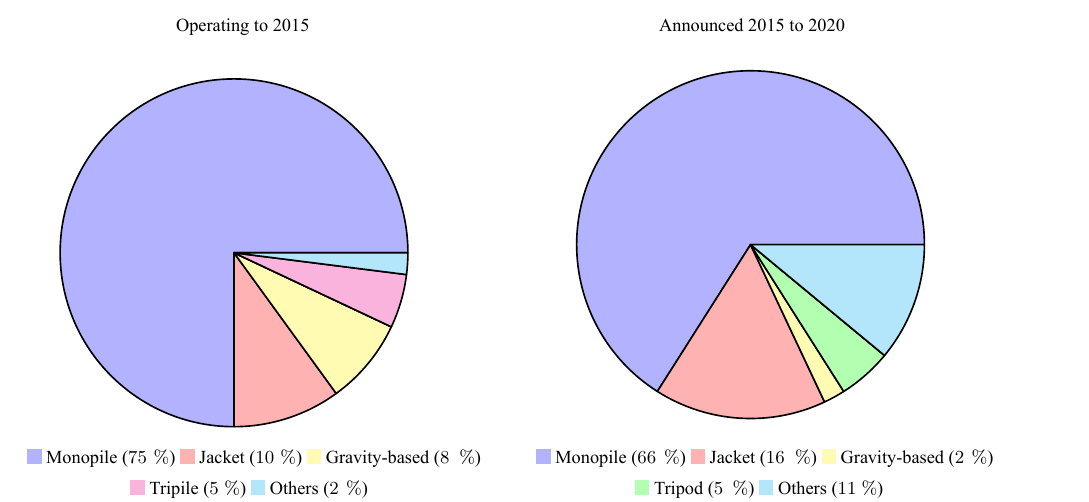
Figure 1. Share of utilized substructures among operating turbines in 2015 and from 2015 to 2020 according to Smith et al.